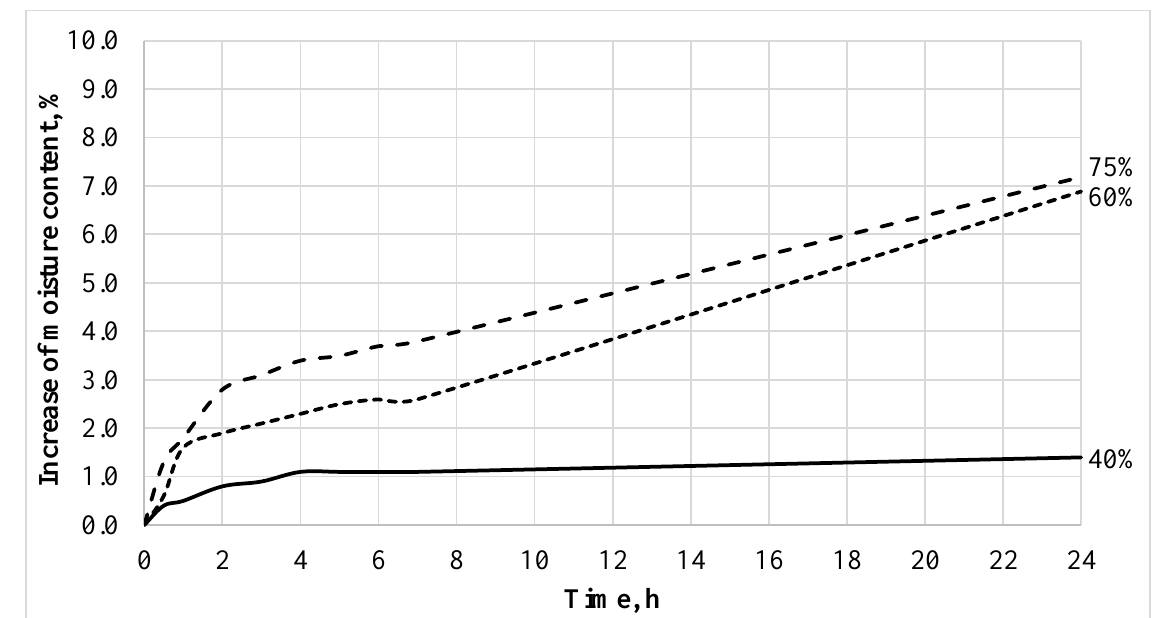
Fig. 3. Moisture absorption of